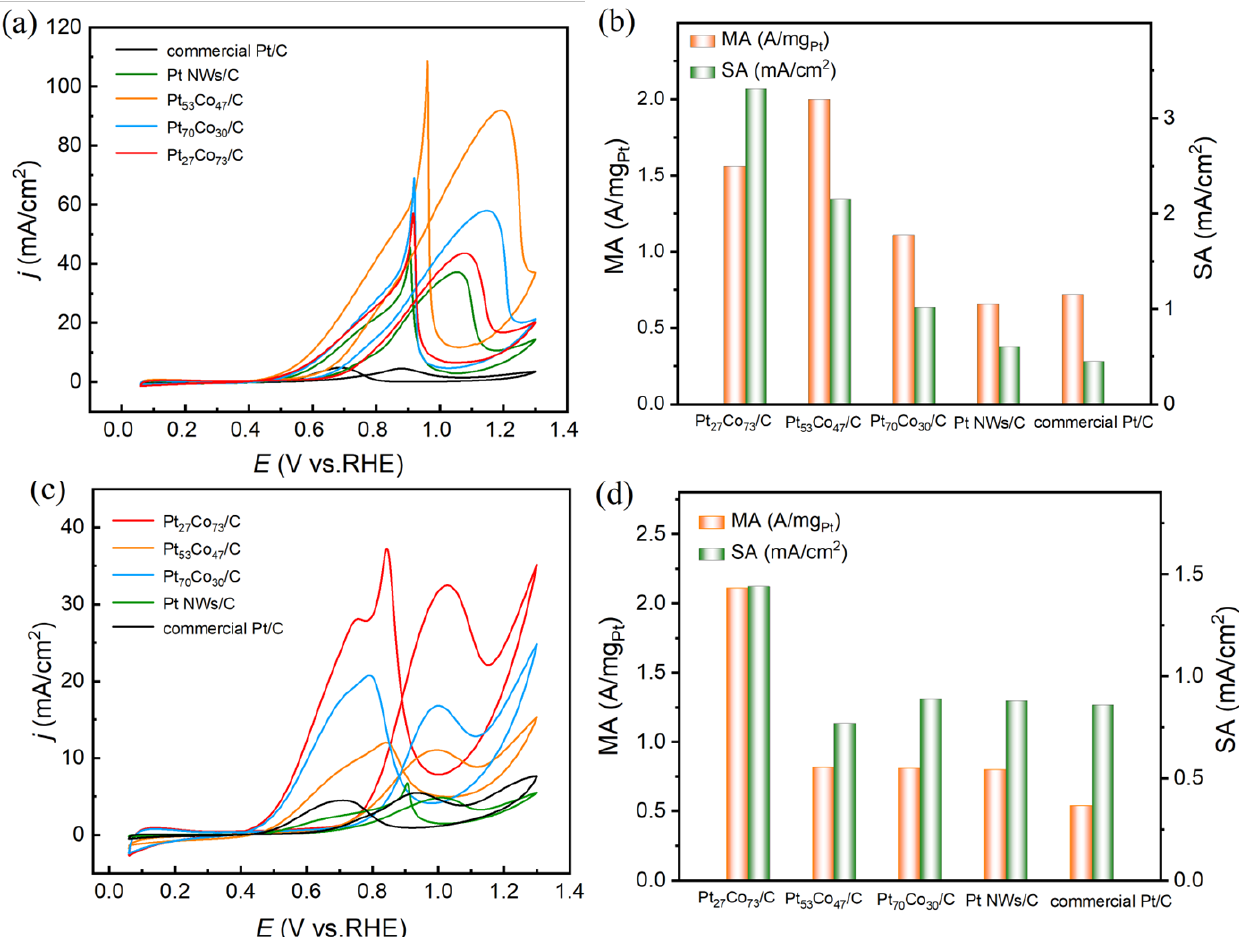
Figure 3. ( a , c ) CV curves of Pt 27 Co 73 /C, Pt 53 Co 47 /C, Pt 70 Co 30 /C, Pt/C and commercial Pt/C in 0.1 M HClO 4 + 0.5 M CH 3 OH/C 2 H 5 OH solution purged with N 2 -saturated solution; ( b , d ) mass activity and specific activity data of methanol oxidation and ethanol oxidation.